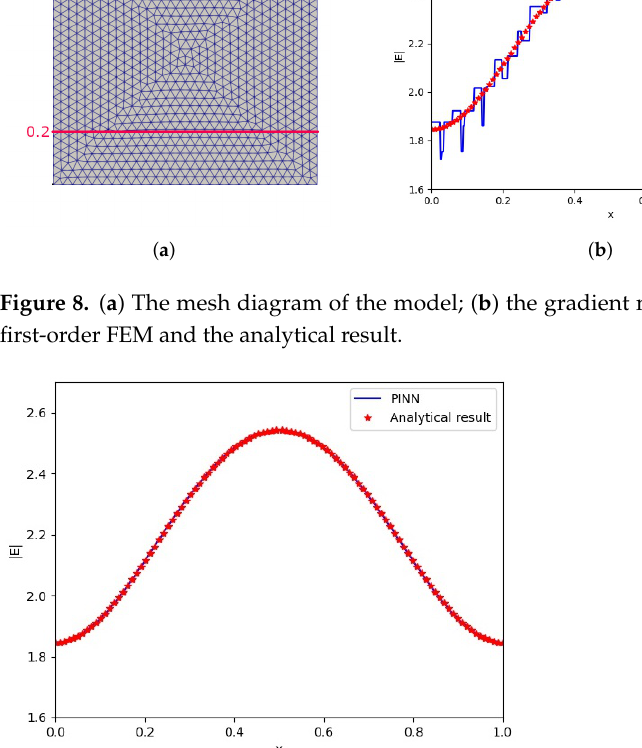
Figure 9. The gradient modulus comparison between the PINN result and the analytical